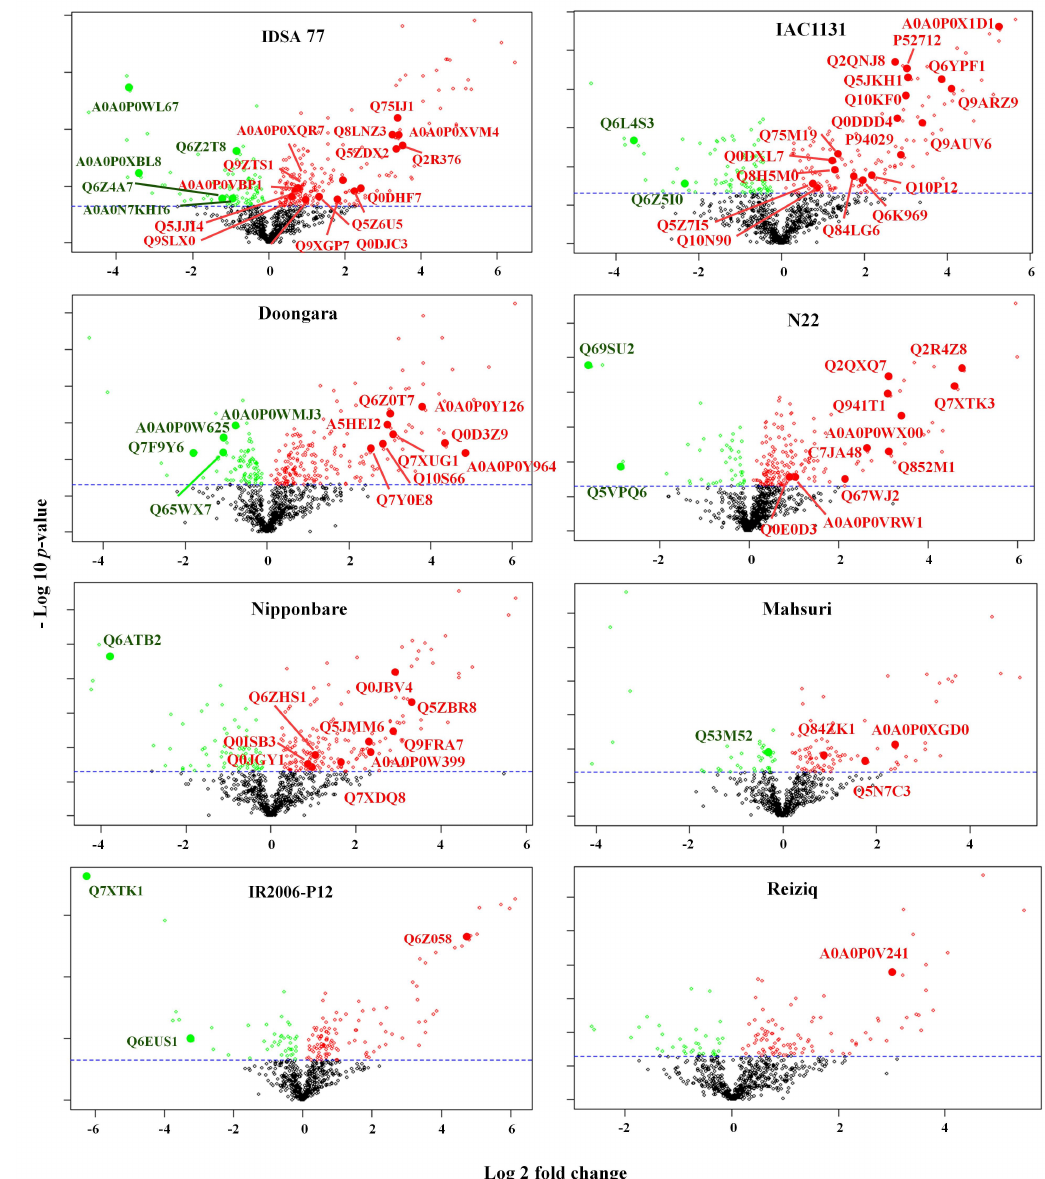
Figure 3. Volcano plots for all unique stress-responsive proteins identified in rice genotypes. Each point represents a protein with an average log 2-fold change along the x-axis (log 2 of the ratio of the average NSAF value in drought stress to the average NSAF value in the control condition) and –log10 p -value along the y-axis. Red, green, and black points show the upregulated, downregulated, and unchanged proteins, respectively. The identifier for unique proteins is shown in each plot. Dashed line shows the p -value of 0.05 cut-o ff